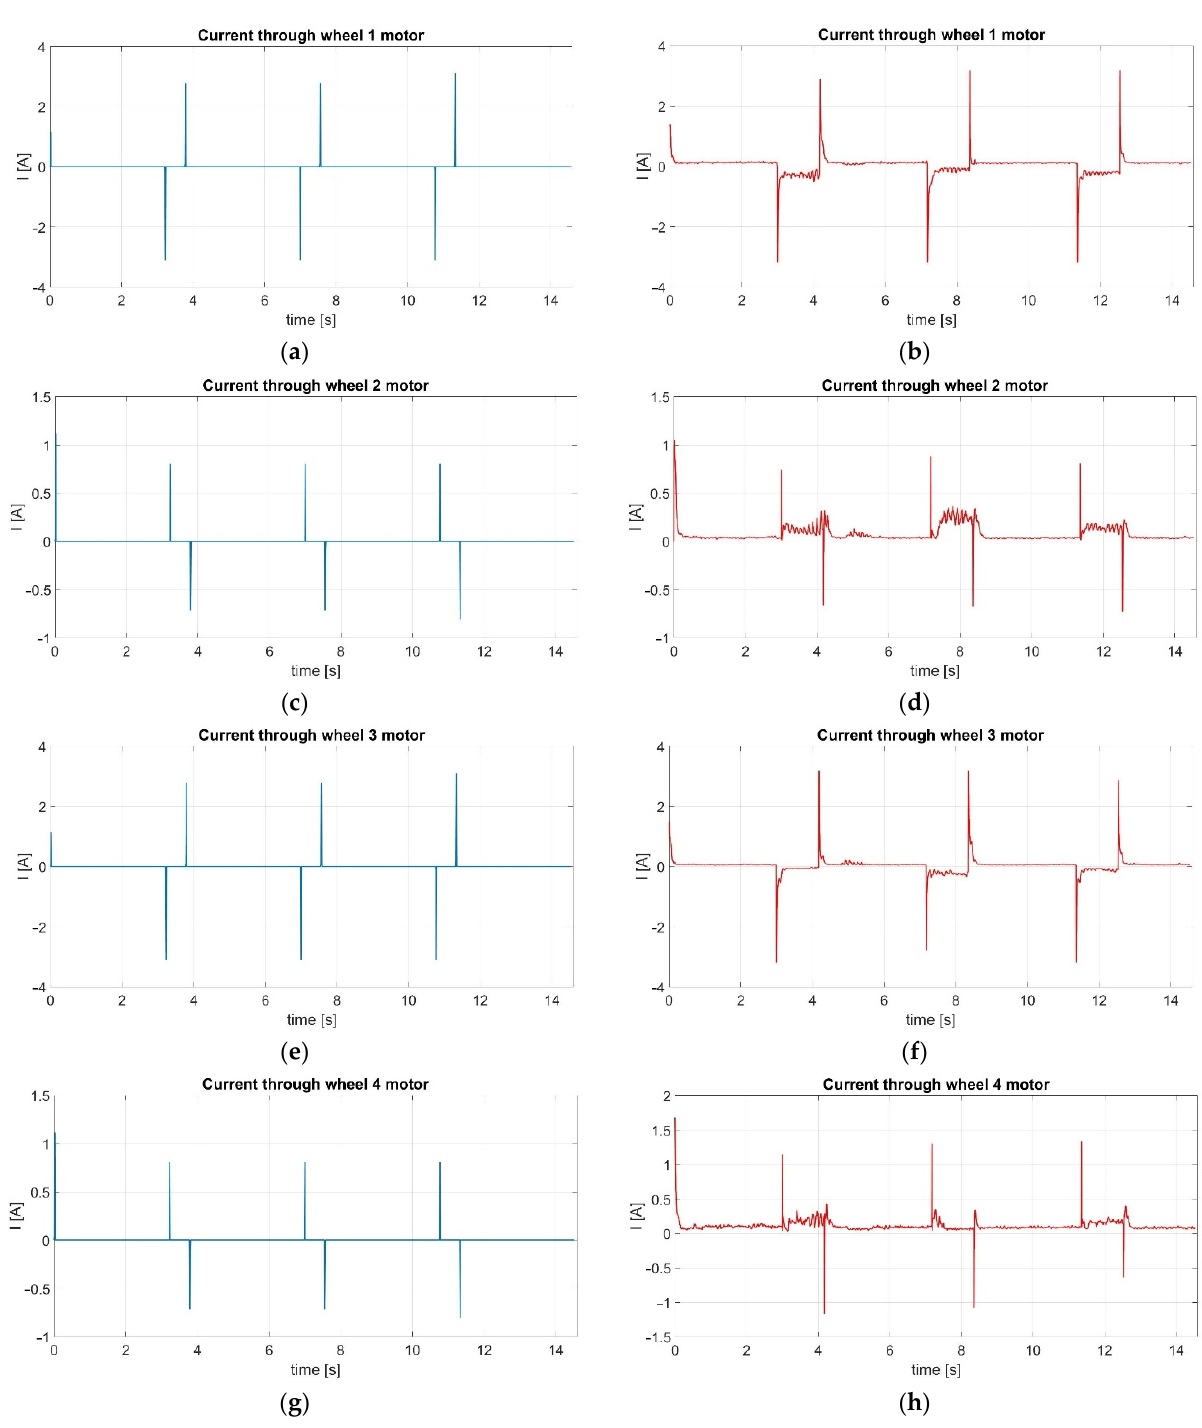
Figure 13. Comparison between simulated ( a , c , e , g ) and measured ( b , d , f , h ) currents through the wheel motors for the differential drive no-loop kinematic solution: ( a , b ) wheel 1; ( c , d ) wheel 2; ( e , f ) wheel 3; ( g , h ) wheel 4.